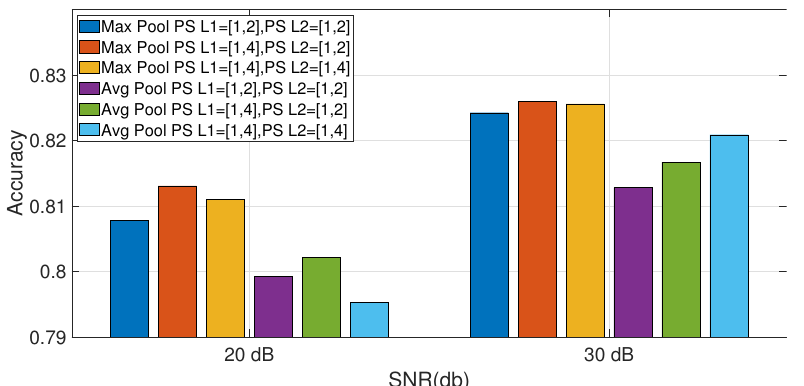
Figure 6. Impact of the pooling size and algorithms on the accuracy with CNN and WHT for SNR = 20 dB and SNR = 30 dB. PS means the Pooling Size, L1 indicates the first pooling layer, L2 indicates the second pooling